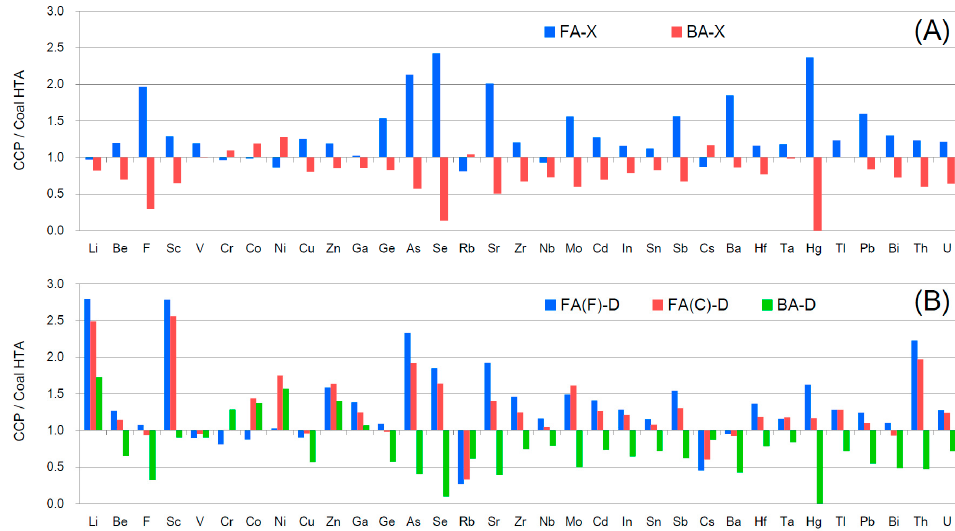
Figure 11. Average enrichment factors of trace elements in the CCPs (ash basis) from the Xilaifeng ( A ) and Damo ( B ) power plants, relative to laboratory coal ashes.